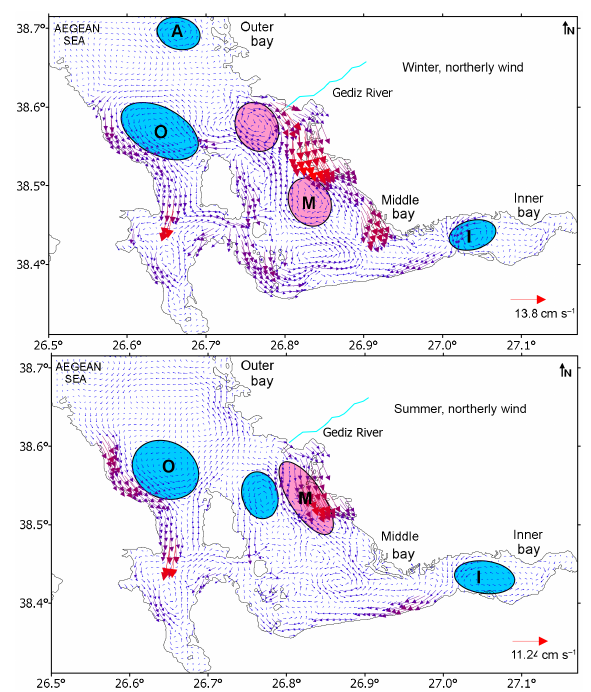
Figure 7. The barotropic current pattern (depth averaged) in the case of a northerly winder in winter and in